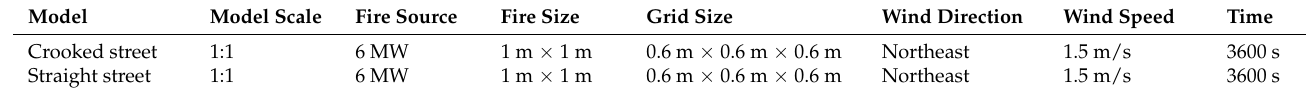
Table 3. Parameter settings for the fire simulation scenarios for comparing street patterns.